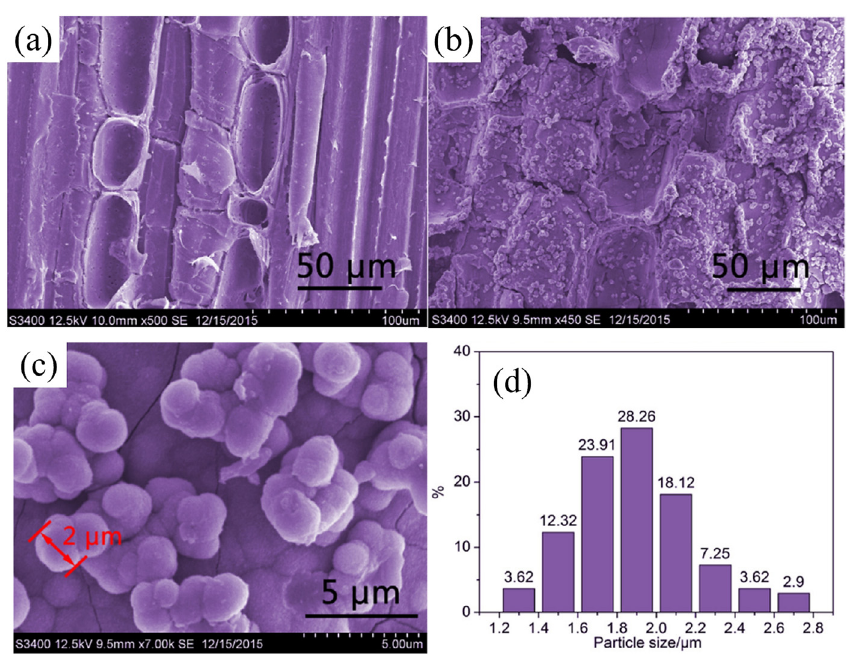
Figure 7: ( a ) SEM images of original bamboo [ 154 ] and bamboo timber coated by TiO 2 ( RT, 7 days ) : ( b ) at low magni fi cation [ 154 ] and ( c ) high magni fi cation [ 154 ] . ( d ) The size distribution of TiO 2 ( RT, 7 days ) [ 154 ]